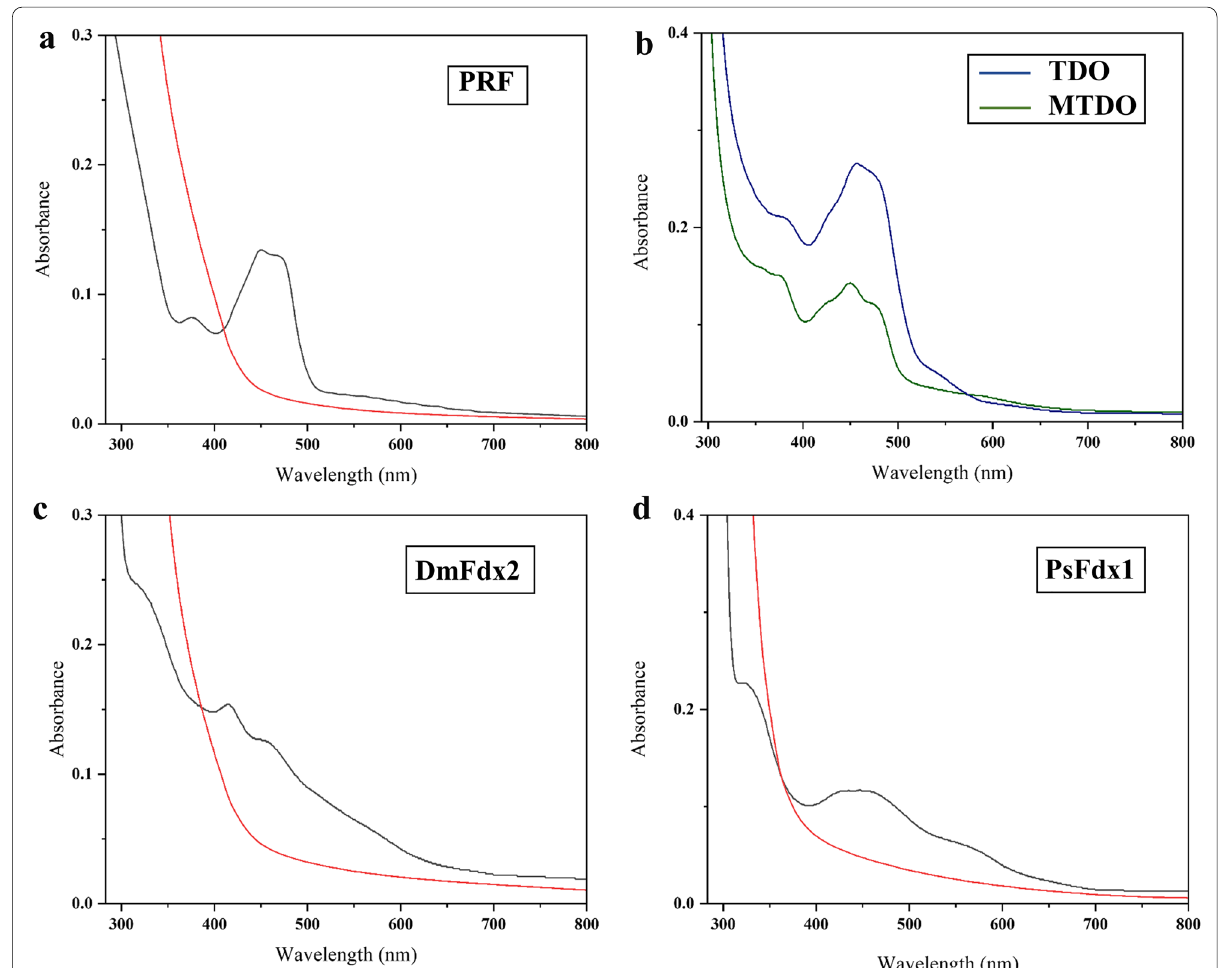
Fig. 3 UV–Vis absorption spectrum of Fdxs and reductase. The UV–Vis absorption spectra of the oxidized state and sodium dithionite‑reduced are black and red, respectively, and shown as a reductase PRF, c DmFdx2 (plant‑type) and d PsFdx1 (Rieske‑type). b Comparison of the UV–Vis absorption spectra of wild‑type TDO (blue) and mutant MTDO